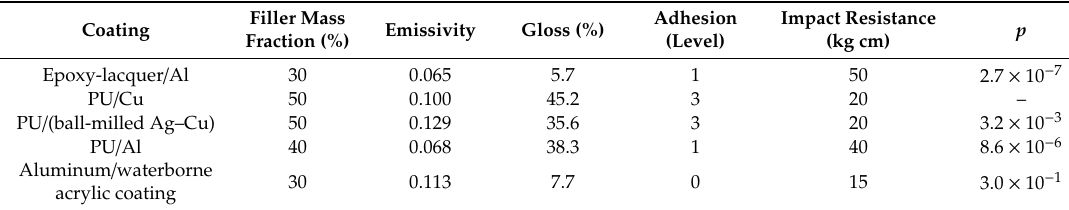
Table 8. Performance comparison of waterborne acrylic based coating with PU based coatings and epoxy-lacquer based coatings.